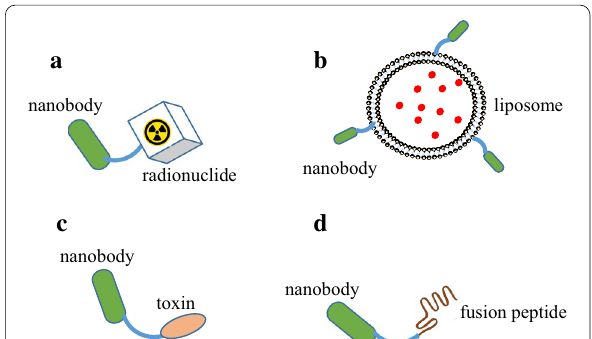
Fig. 2 Nanobody-based targeted disease therapy. Owing to their superior target specificity and binding affinity, nanobodies often serves as targeting moieties and brings effector domains or drugs to lesions of interest, including radionuclide ( a ), drugs ( b ), toxins( c ), and fusion peptides ( d